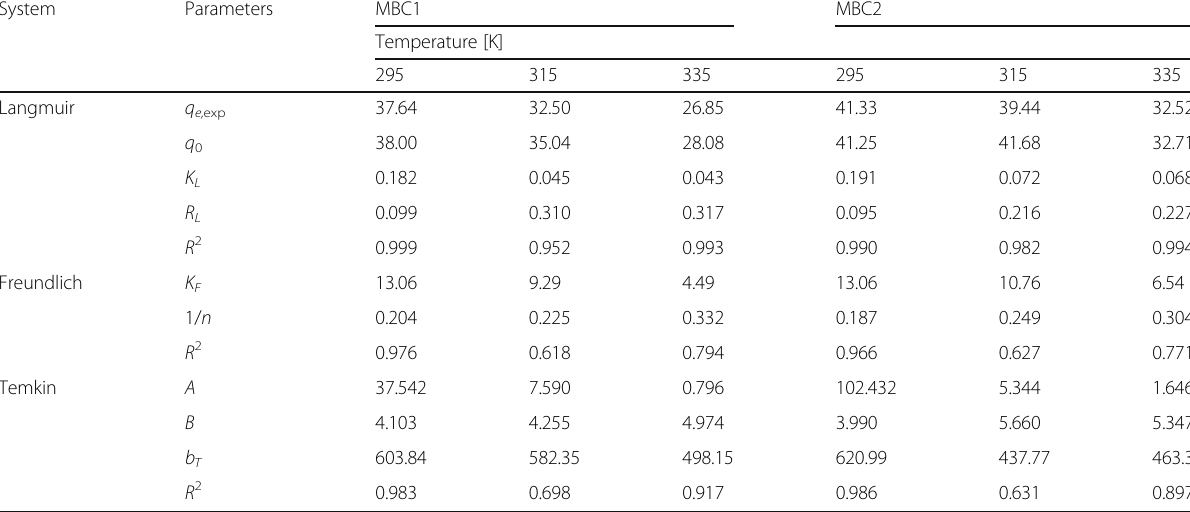
Table 4 Adsorption isotherm parameters and correlation coefficients as a function of temperature for the adsorption of Cd(II) on MBC1and MBC2 System Parameters MBC1